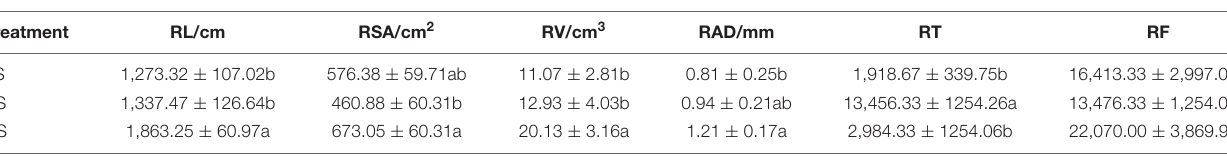
TABLE 2 | Morphological root characteristics under different soil